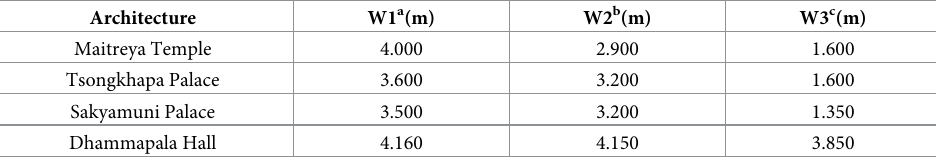
Table 2. Dimensions of the planar column network of the palace space for type I. Architecture